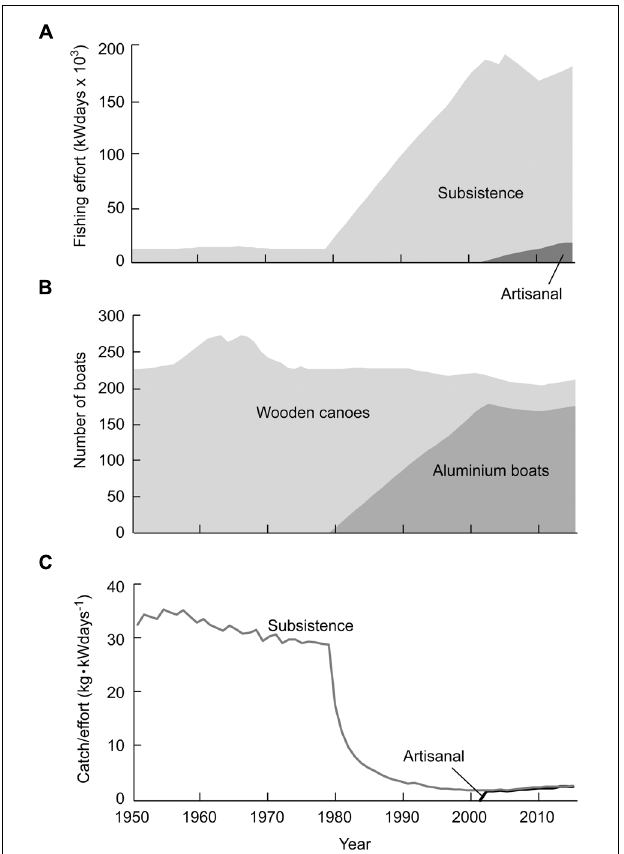
FIGURE 3 | Fishing effort for the domestic, small-scale fisheries in Tokelau as (A) fishing capacity (kWdays) by fishing sector; (B) total number of vessels by vessel type from 1950 to 2016; and (C) catch-per-unit-effort (CPUE) of Tokelau’s domestic subsistence and artisanal fisheries from 1950 and 2003, respectively, until